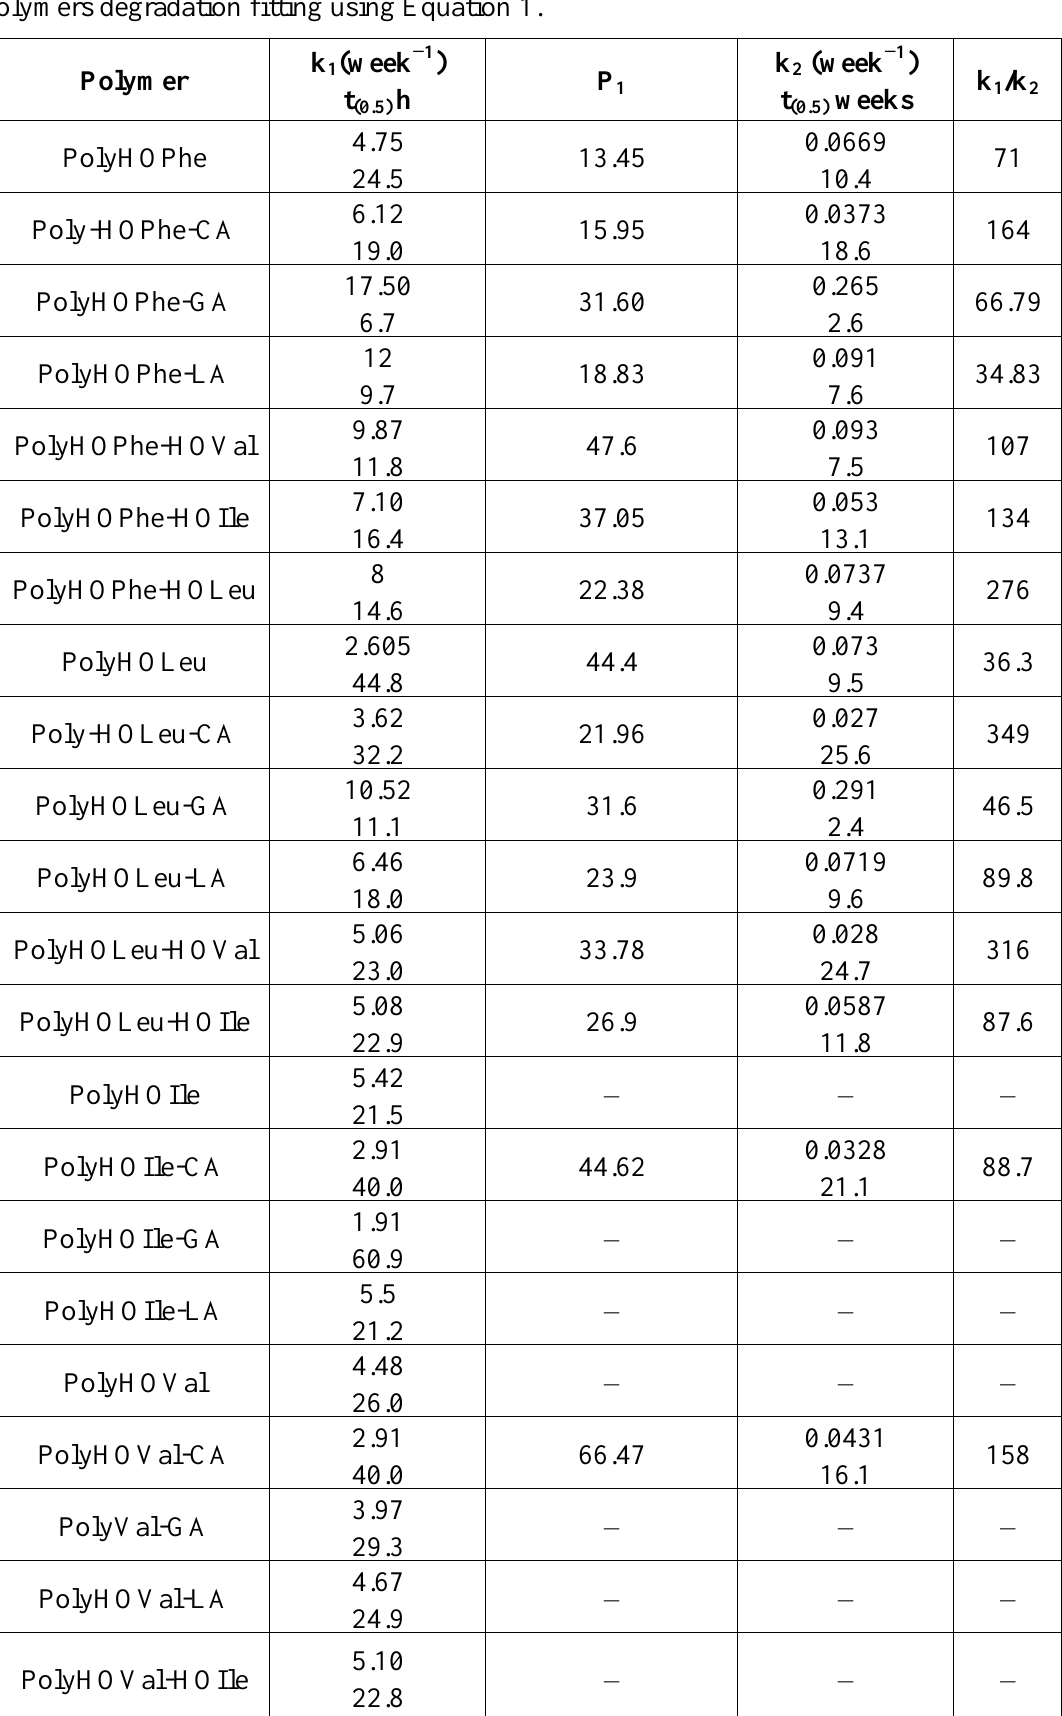
, k , P and t of each step) resulting from 1 2 1 (1/2)